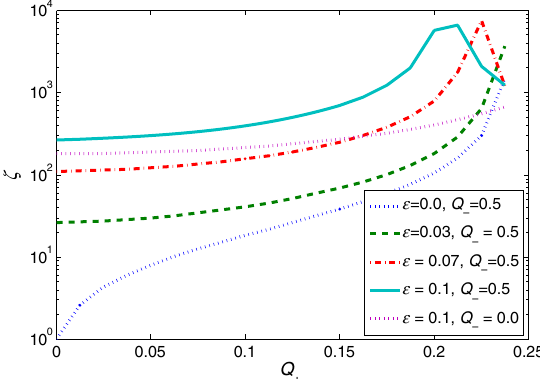
FIG. 8. The dynamical range of the phase gate as a function of ¼ the total gate charge Q ¼ ð Q 1 þ Q 2 Þ (units of 2 e ) for a set of þ þ values of the Josephson asymmetry ϵ and Q − ¼ Q 1 − Q 2 (expressed in units of 2 e ). Note the resonances in the dynamic range as the qubit states are tuned to degeneracy.